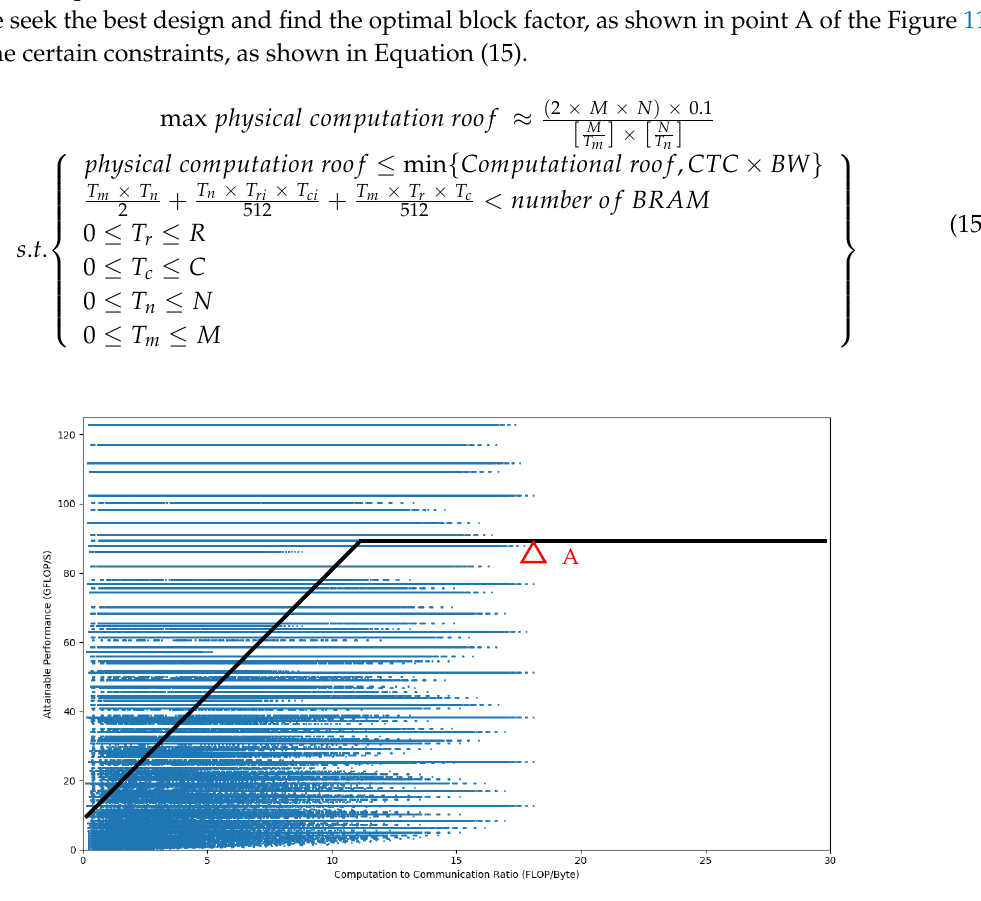
Figure 11. Design Figure 11. Design exploration.